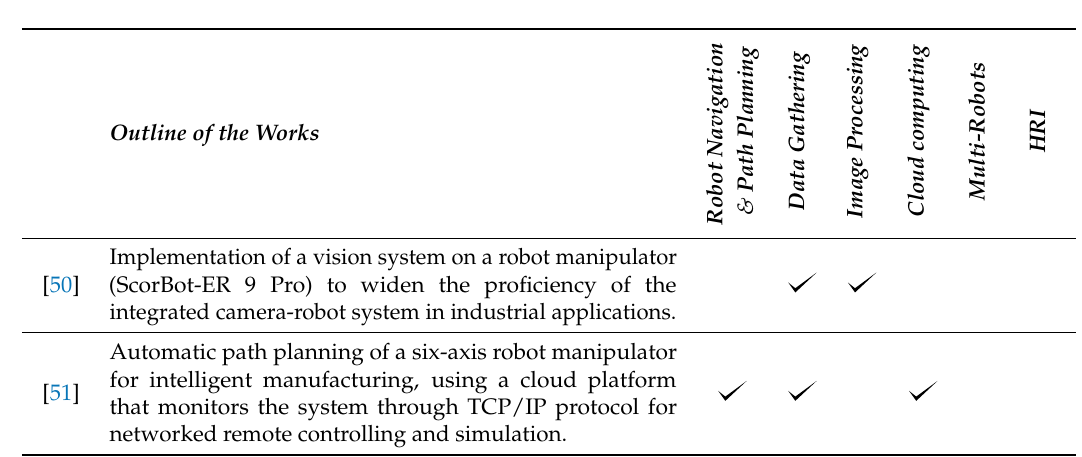
Table 1. Overview of the literature considered for the Manufacturing domain, from 2018 onwards.